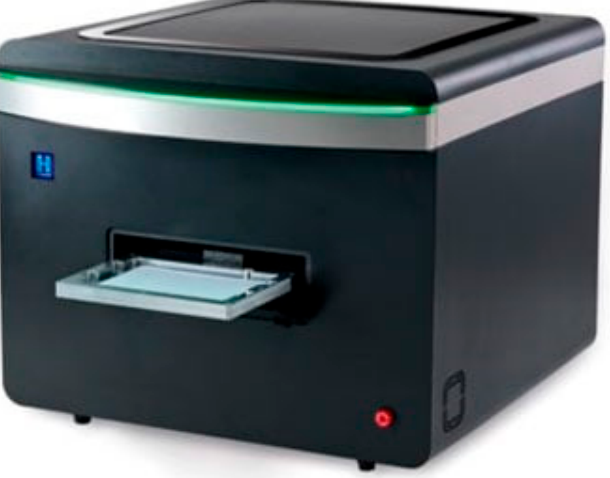
Figure 4. Mail inspection system based on terahertz TDS [25]. An automated XY-scanner accepts the envelopes to be inspected.